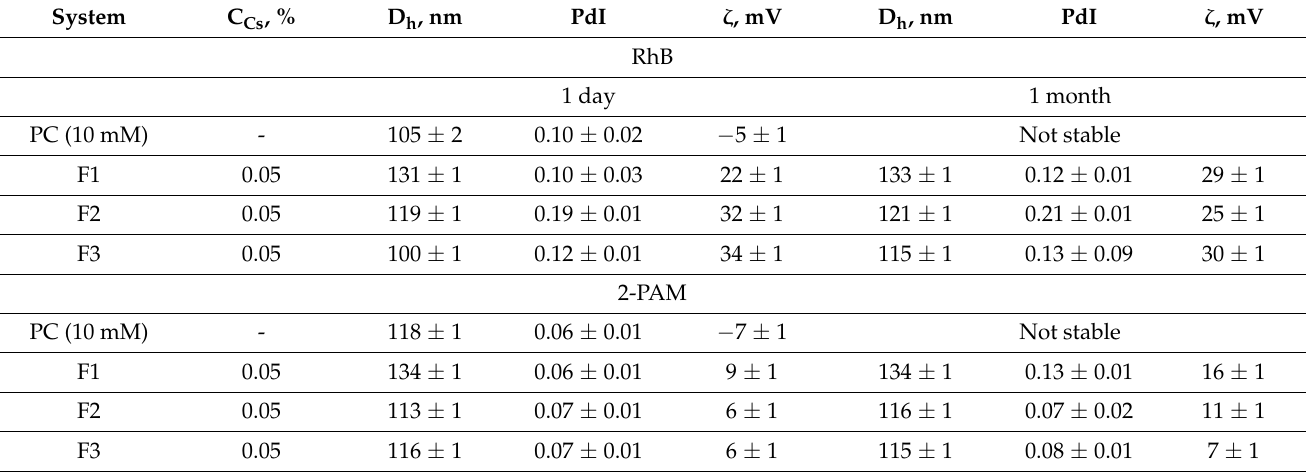
Table 3. Physicochemical characteristics of RhB- or 2-PAM-loaded liposomes and chitosomes, modi- fied with various polymers (0.05%) and storage time: hydrodynamic diameter (D h , nm); polydisper- sity index (PdI), and zeta potential ( ζ , mV).